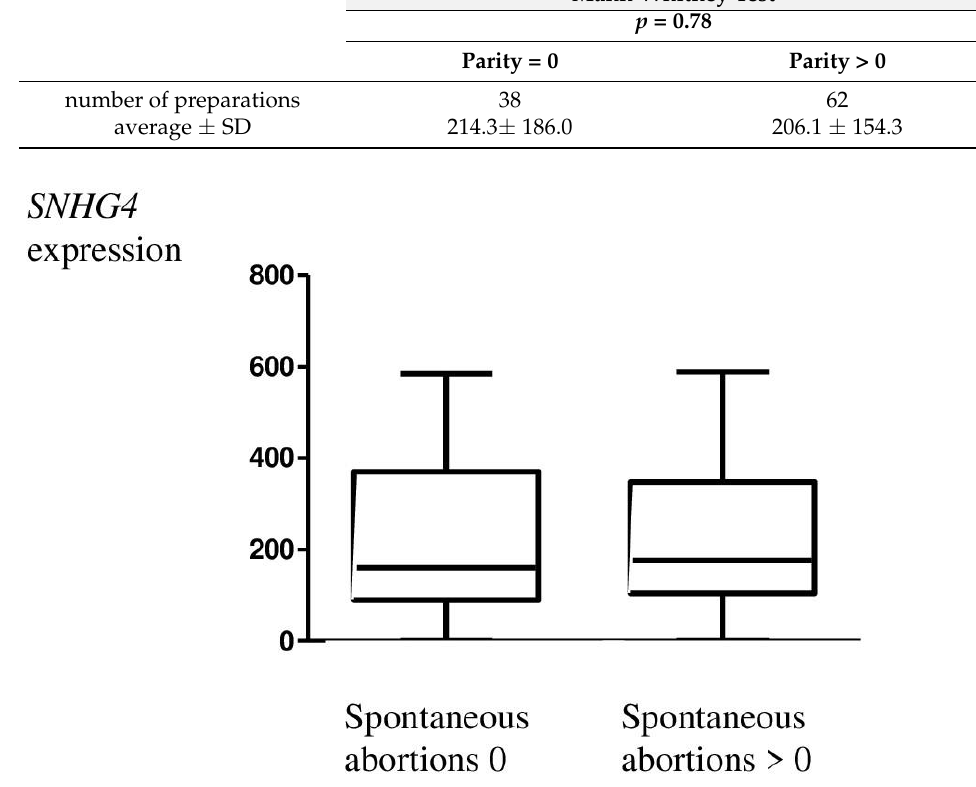
Figure 5. Relative expression of the SNHG4 gene in endometriosis patients with respect to the rASRM classification (Mann – Whitney test; p = 0.031).